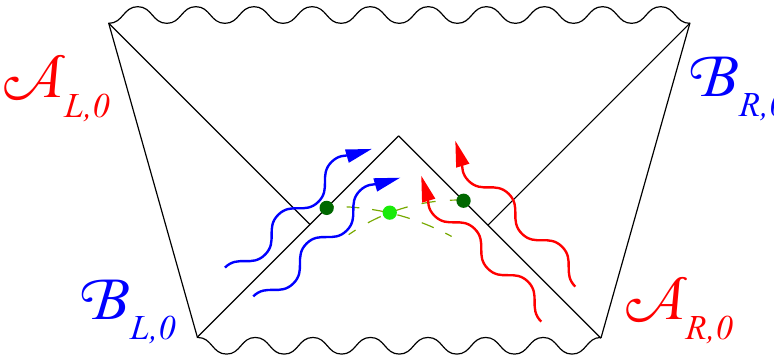
Figure 8 . In a wormhole containing two shocks there are two “throat” quantum extremal surfaces (dark green). One lies inside the left shock and entirely to the left of the right shock; the other lies inside the right shock and entirely to the right of the left shock. A “bulge” surface (light green) lies in between the two, and is entirely in the past of both shocks. The dashed green lines represent families of surfaces with zero quantum expansion in the past and future rightwards null directions respectively. Their intersection determines the location of the bulge